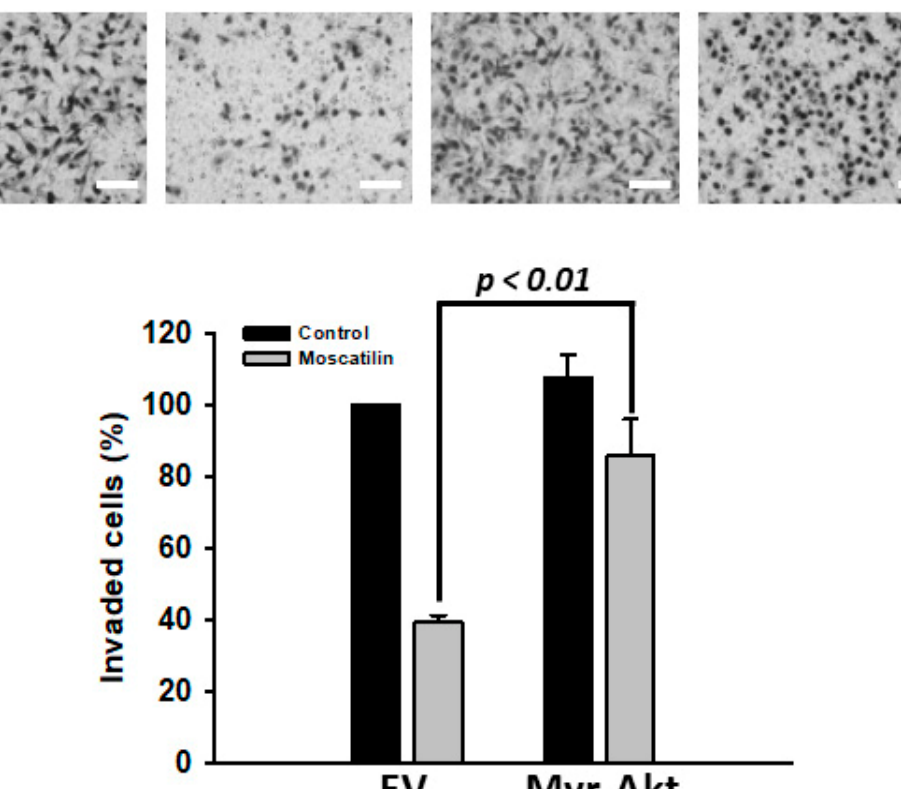
Figure 7. Overexpression of Akt prevents moscatilin-induced anti-invasive function. ( A ) SK-Hep-1 cells-transfected with empty vector (EV) or Myr-Akt (Myr) were harvested and lysed for the detection of p-Akt by Western blot analysis. ( B ) Transfected cells were seeded onto the upper chamber coated with Matrigel, then treated with (30 µ M, M) or without (control, C) moscatilin for 12 h in medium containing 10% FBS as a chemoattractant in the lower chamber. Data are expressed as mean ± S.E.M. of four independent experiments. * p < 0.05, and *** p < 0.001 compared with the EV-transfected group. Scale bar, 50 μ m.